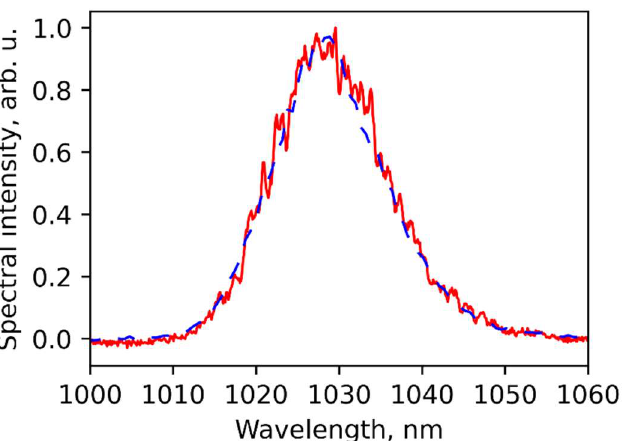
Figure 5. Spectrum of radiation passed through the MCF when the out-of-phase supermode was selectively excited (solid red line). Spectrum of seed radiation (dashed blue line).